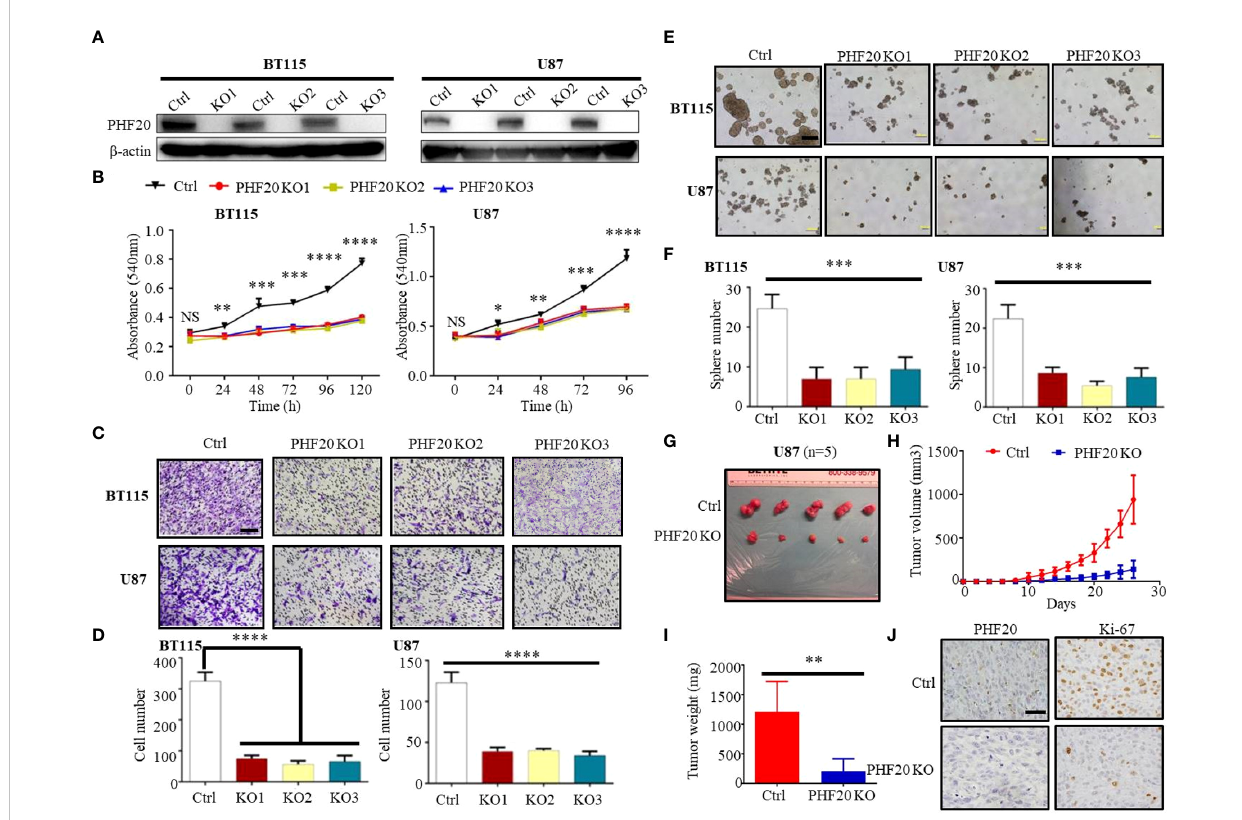
FIGURE 1 PHF20 is highly expressed in GBM, and increases cellular viability, proliferation and invasiveness of GBM cells in vitro and in vivo . (A) Demonstration of ablation of PHF20 in BT115 and U87 GBM PHF20 KO cells by western blotting analysis. PHF20 KO clones were generated with PHF20 sgRNA #1, #2, and #3. Cells transfected with non-speci fi c sgRNA were used as control. (B) A total of 5,000 wild-type (WT) and PHF20 KO BT115 cells and 10,000 WT and PHF20 KO U87 cells were plated in a 96-well plate using 200 m l medium. Cell viability was assayed using an MTT assay (540 nm). Both PHF20 KO BT115 and U87 cells showed signi fi cantly reduced cell viability compared to control. (C) PHF20 KO and its control cells were subjected to transwell Matrigel invasion assays. Scale bar, 50 m m. (D) The quanti fi cation of migrated cells through Matrigel for each cell line. Scale bar, 100 m m. (E) A tumor sphere formation assay was performed to assess the self-renewal capacity of WT and PHF20 KO cells. Five random wells were photographed. (F) The quanti fi cation of the sphere number after 7 days for each cell line. (G) Representative xenografts excised from PHF20 KO and control groups of NSG mice (n = 5). (H) Growth of tumors following the subcutaneous injection of PHF20 KO and control cells. (I) The tumor weight of subcutaneous xenografts formed by U87 WT and PHF20 KO cells. The knockout group is remarkably decreased the tumor volume and weight. (J) IHC staining of PHF20 and Ki-67 of xenografts. Scale bar, 50 m m. Data are plotted as the mean ± SD of three independent experiments. *P < 0.05; **P < 0.01; ***P < 0.001 compared to the controls using Student ’ s